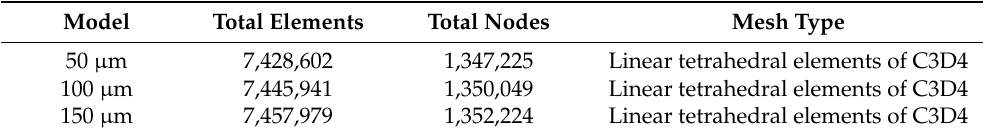
Table 3. Nodes and elements for tested